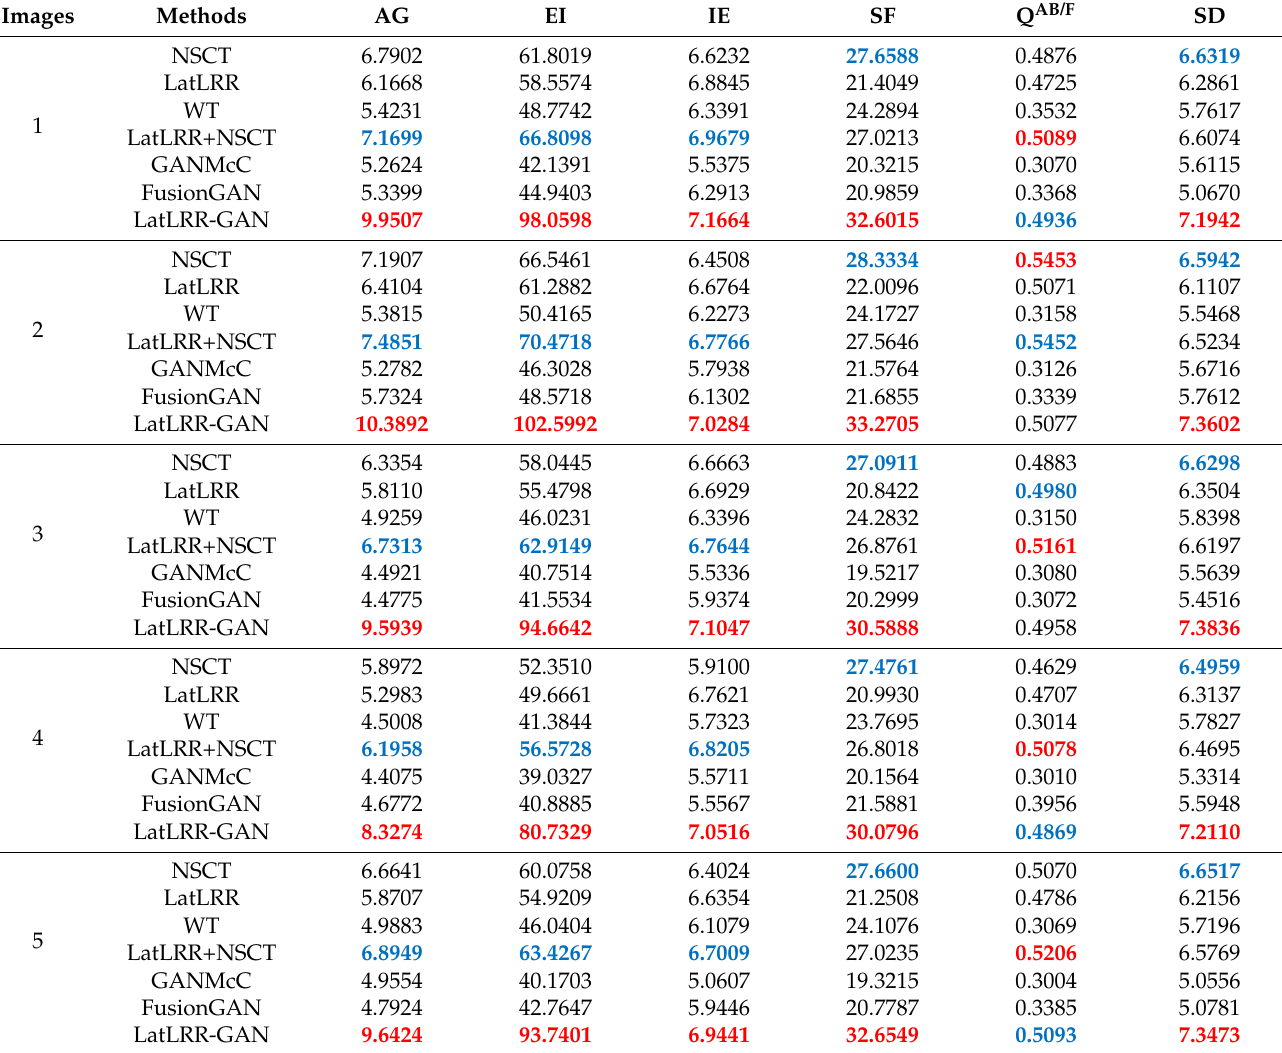
Table 1. The results of fused images’ evaluation metric values of CT lung window images